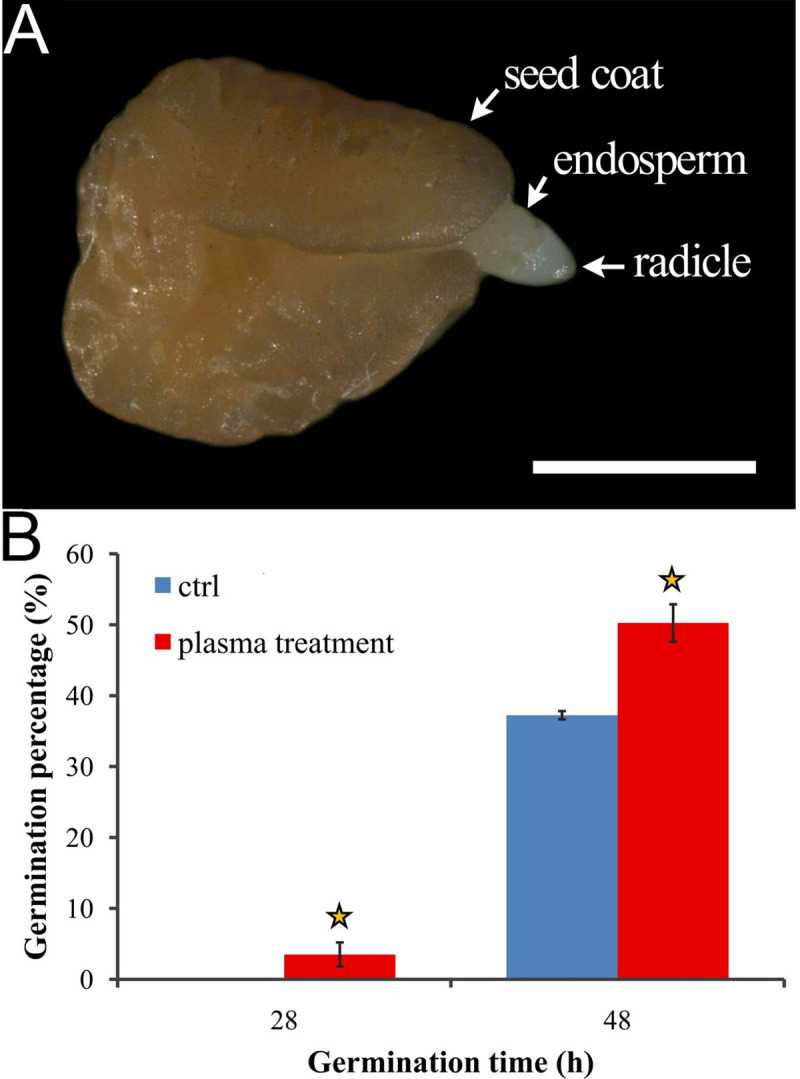
Seed germination characteristics of A. paniculata before and after air plasma treated.(A) The radicle protruding the endosperm and seed coat at 28 HAS. The scale bar is 1 mm. (B) Seed germination characteristics of control and treated groups at 28 and 48 HAS. Replications = 4. Data are shown as the mean ± SD. The asterisk indicates a significant difference (P < 0.05).